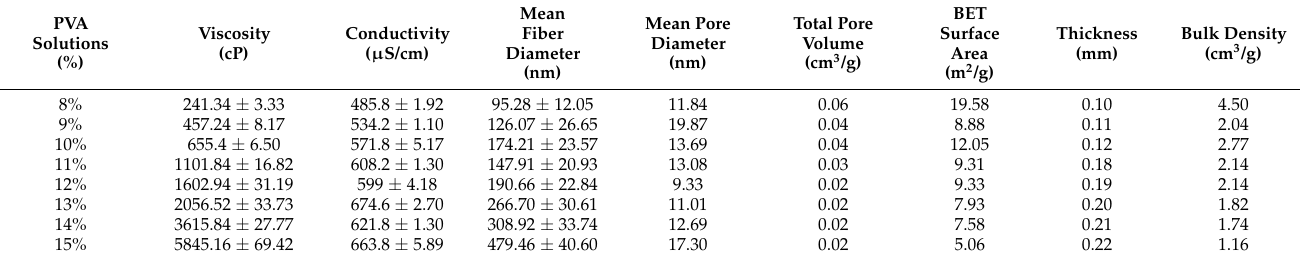
centration. Table 1. Physical properties of the spinning solutions and electrospun fibrous membranes.